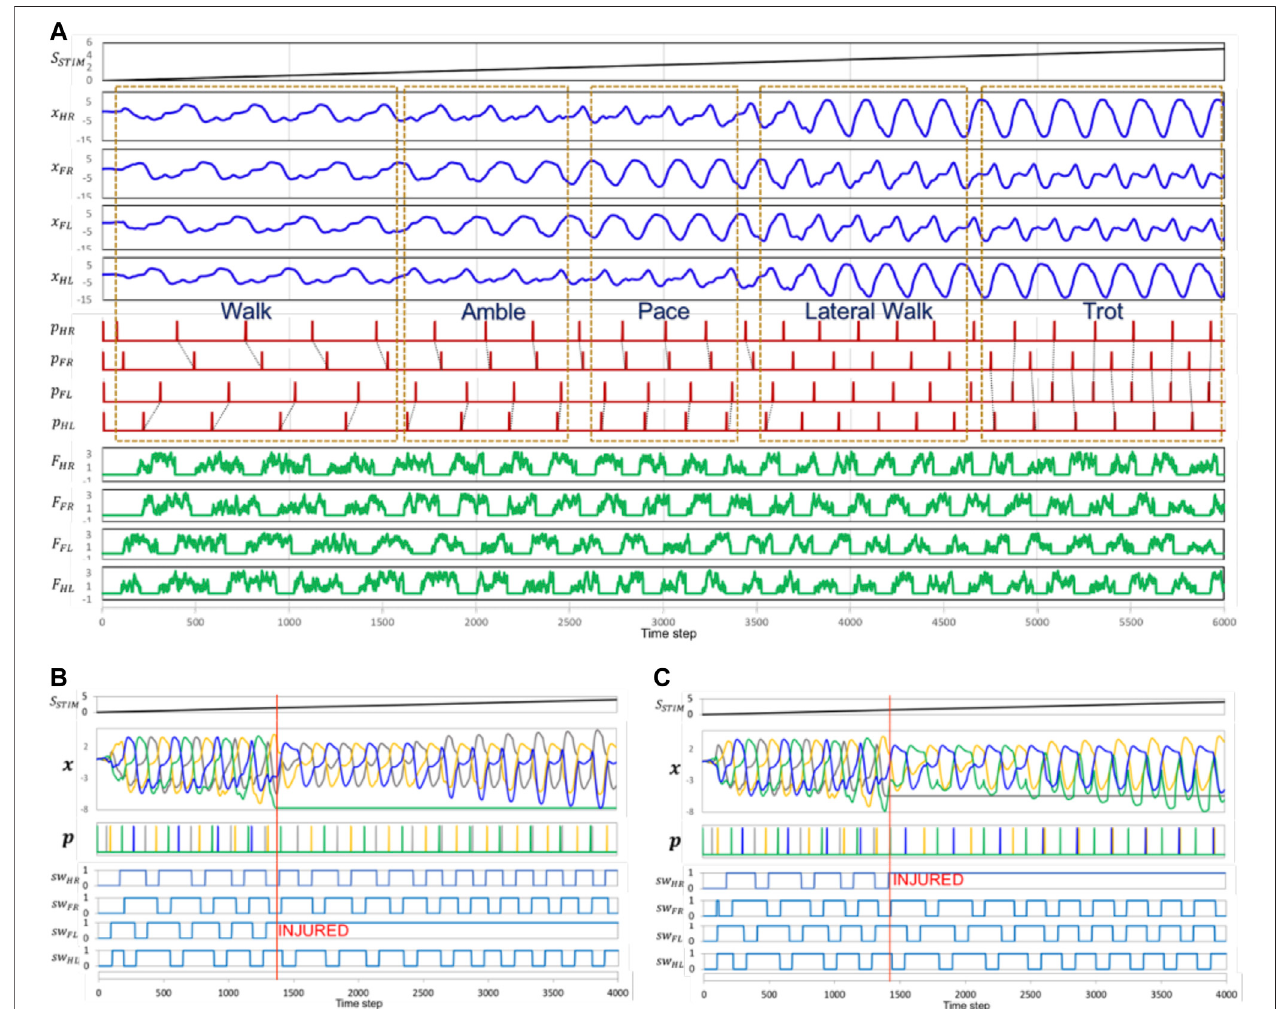
FIGURE12|(A) Thelocomotionmodelcangeneratedynamicgaitpatternbygivingdifferentspeedstimulation.Itshowsthereare fi vedifferentknowngaitpatterns fromslow speedtohighspeed.TheCPGmodelcangenerateadynamicgaitpatternthroughdifferingspeedstimulation S STIM .ThisincreasesthefrequencyoftheCPG outputs x of fi ve different known gait patterns from slow speed to high speed. Parameter F HR , F FR , F HL , F FL shows the ground reaction force for every limb. (B) The generatedgaitpatternsinmalfunctionconditionsandthespeedstimulationresponses.Thesignalpattern p ischangingtorespondtotheabsenceofCPGsignals. Thetimephasedecreasesafteralegisinjured.Themalfunctionoftherightforelimb( N FL (cid:2) 1)isattimestep1380.Duringinjury,themodeltendstogenerateapatternwith thesamephase differenceatalowerspeed.Athighspeeds, leftandrighthindlimbsfeaturethesamephase. (C) malfunctionofthelefthindlimbattimestep1400.Inthis condition, the left and right forelimbs feature the same phase at a higher speed.